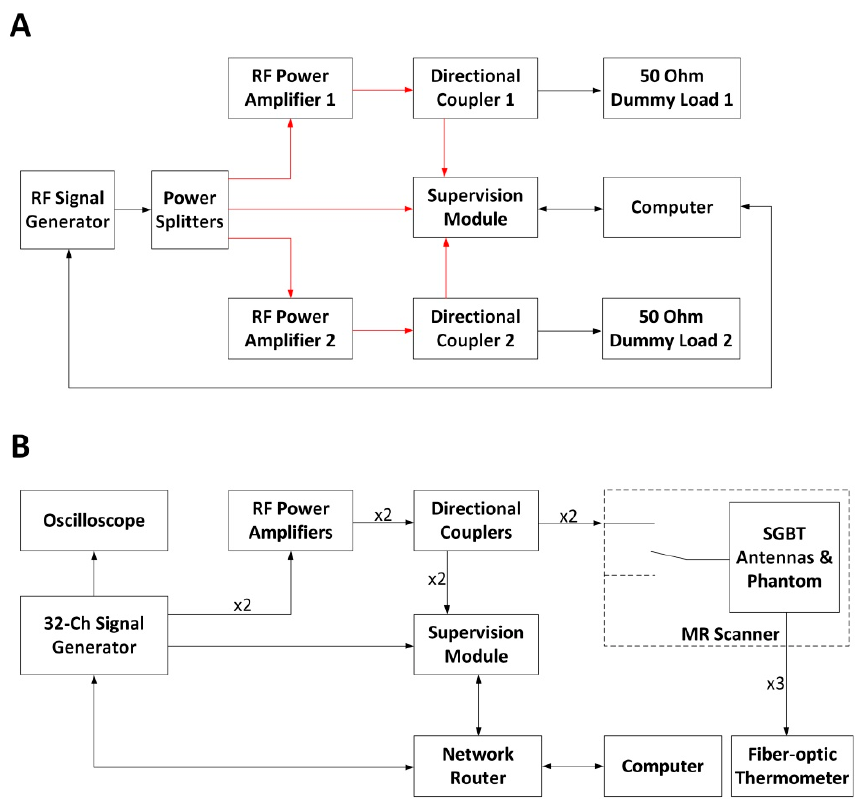
Figure 3. ( A ) Schematic of the experimental setup used for the RFPA (RF power amplifier) characterization. The connections illustrated in red share the same cable length. The power splitters and the directional couplers were characterized using a vector network analyzer (ZVT8, R&S) so that the unbalances in the two RF signal chains could be compensated during the characterization of the